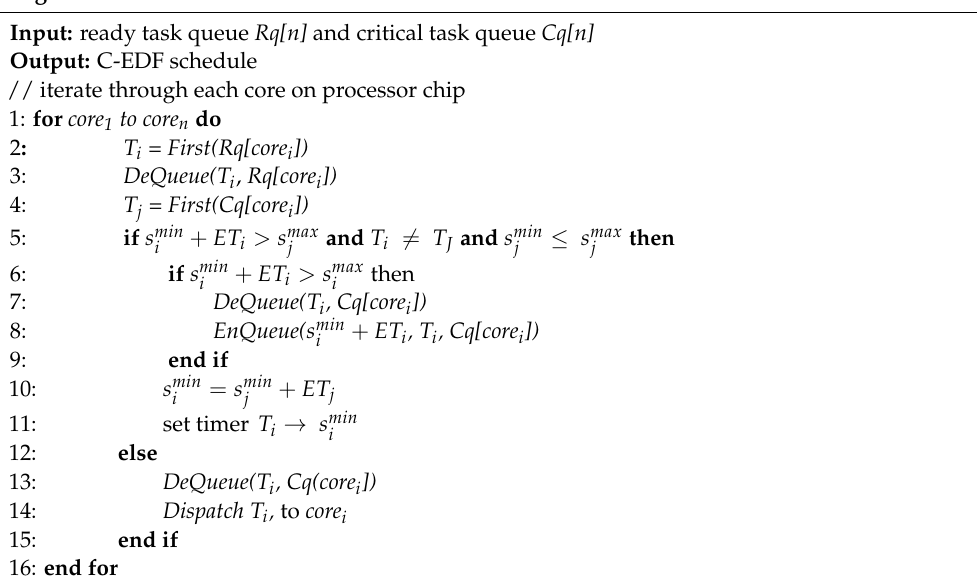
Algorithm 3. C-EDF Scheduler